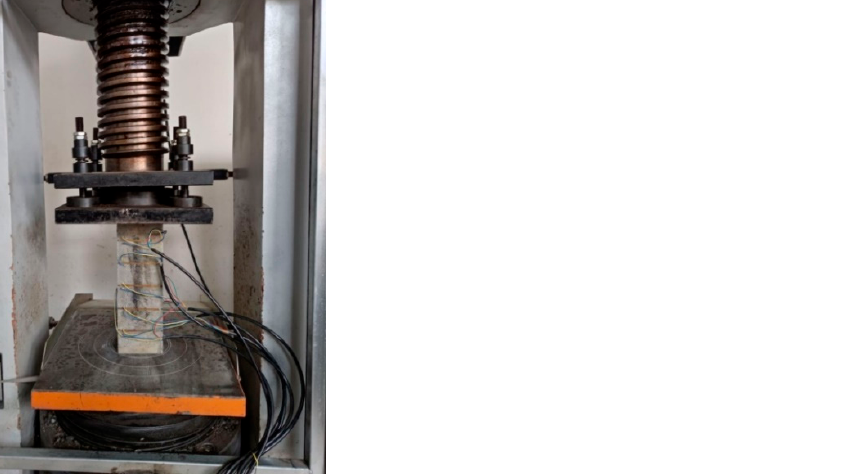
Figure 2. WHY-2000 electro-hydraulic servo pressure testing machine.